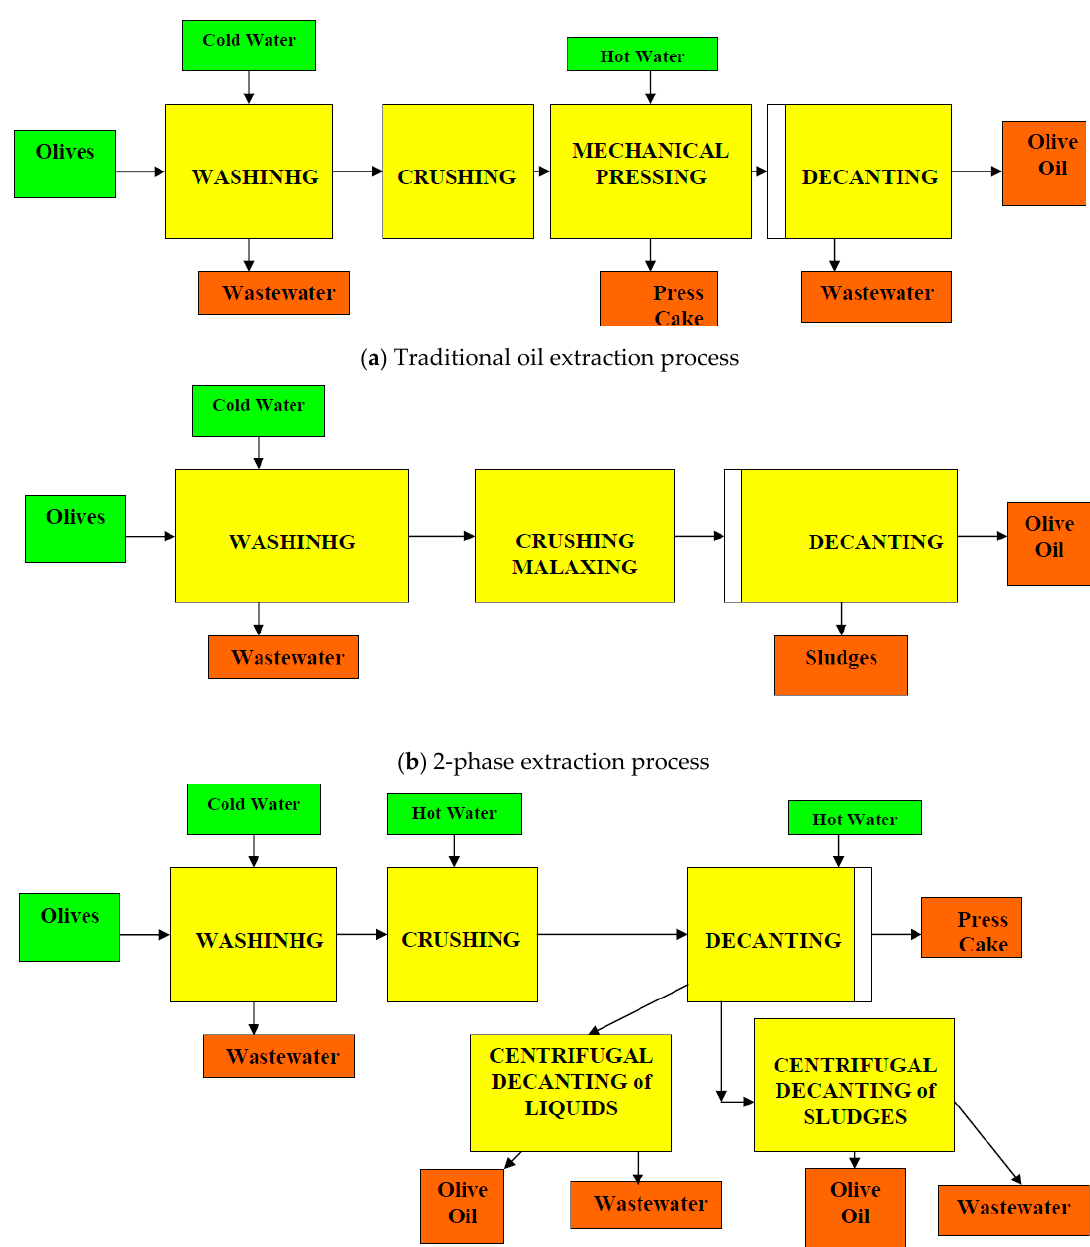
Figure 1. Process flow chart of olive oil extraction methods. Table 1. Approximate input output analysis of water consumption and byproducts generated at olive oil mills [3,30,31].